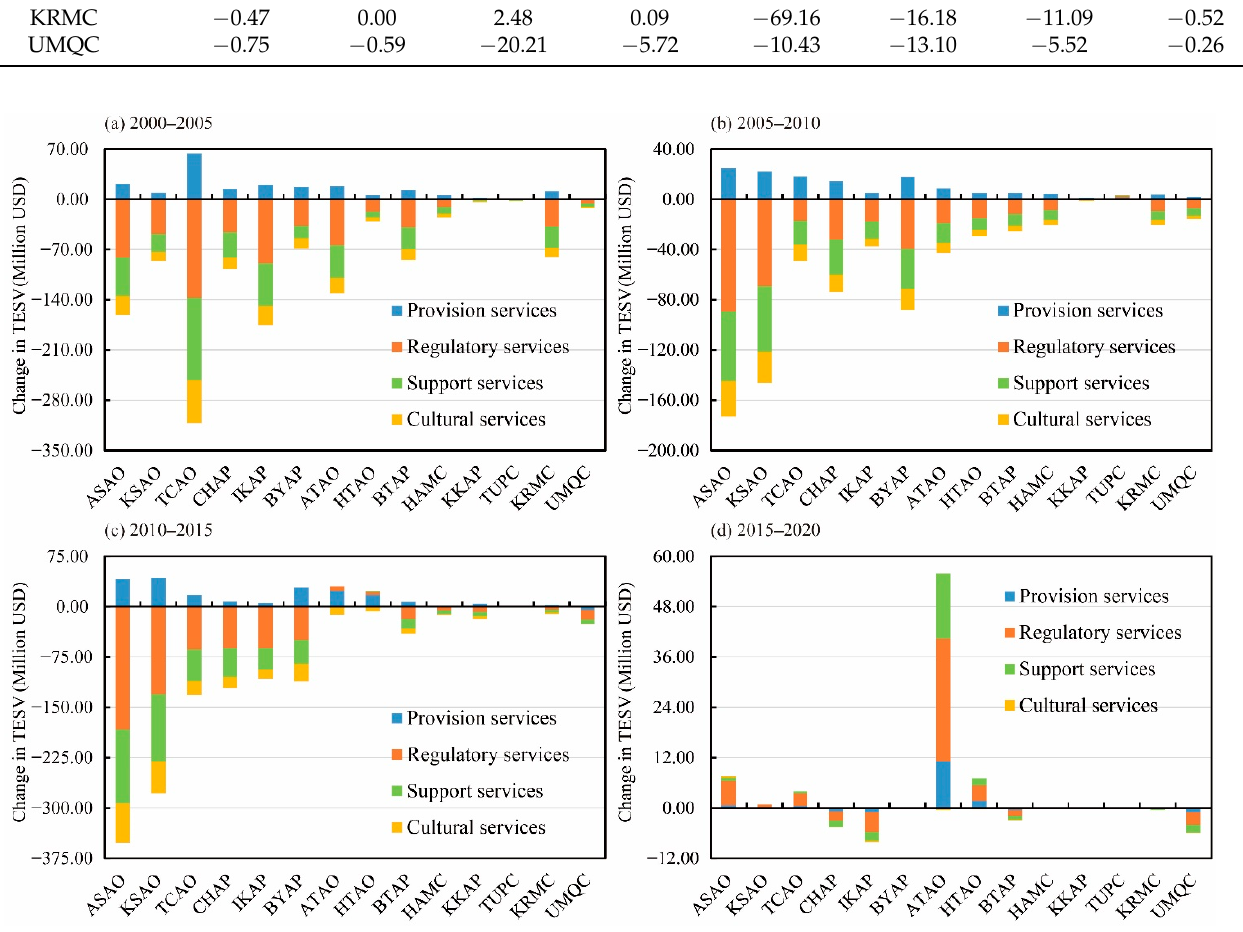
Figure 7. Net changes in four types of the TESV caused by the cropland conversion in different prefectures of Xinjiang during 2000–2020. Table 9. Changes in the TESV caused by the conversion of cropland in different prefectures of Xin- jiang during 2000–2020.